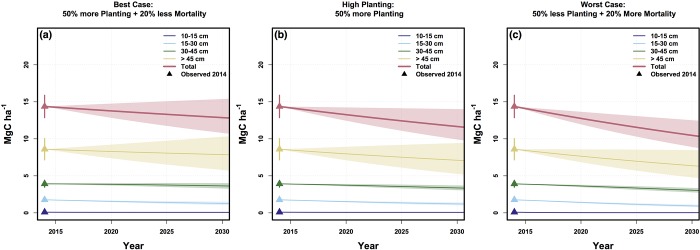
Scenarios.Projected aboveground carbon pools in Boston street trees between 2014 and 2030 under various changes to current planting and maintenance regimes. Triangles represent 2014 observations with a 95% confidence interval. Pools are broken up by size class with the total carbon storage represented in red. Models were run 1000 times and shaded polygons represent the middle 95% of model observations.